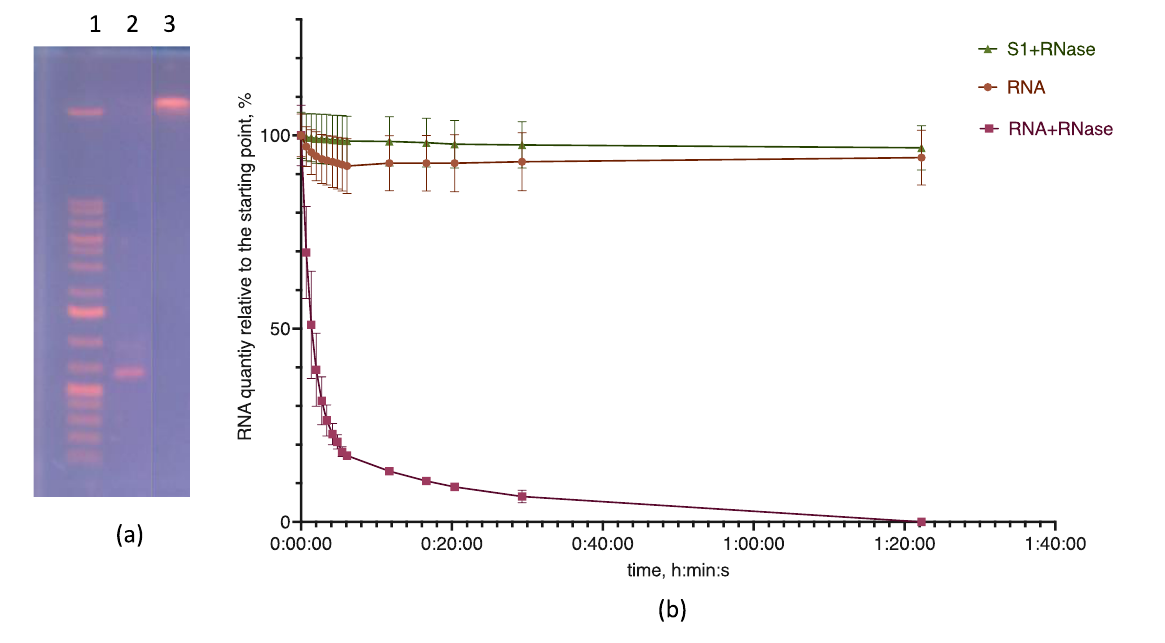
Figure 3. Electropherogram and kinetics of mRNA hydrolysis and mRNA–LNP lipoplex by RNase A. ( a ) Electropherogram of LNP (sample S1b) lipoplex sample: 1—markers; 2—mRNA; 3—LNP S1b and mRNA. ( b ) Kinetics of mRNA and lipoplex with LNP (sample S1b) hydrolysis. Values are given as percentages relative to the starting point of each sample. Tris–borate–EDTA buffer, 8.0 pH, 200 ng of mRNA, and 0.05 units of RNase A (Thermo). LNP sample S1 composition is given in Table 2, n = 3.